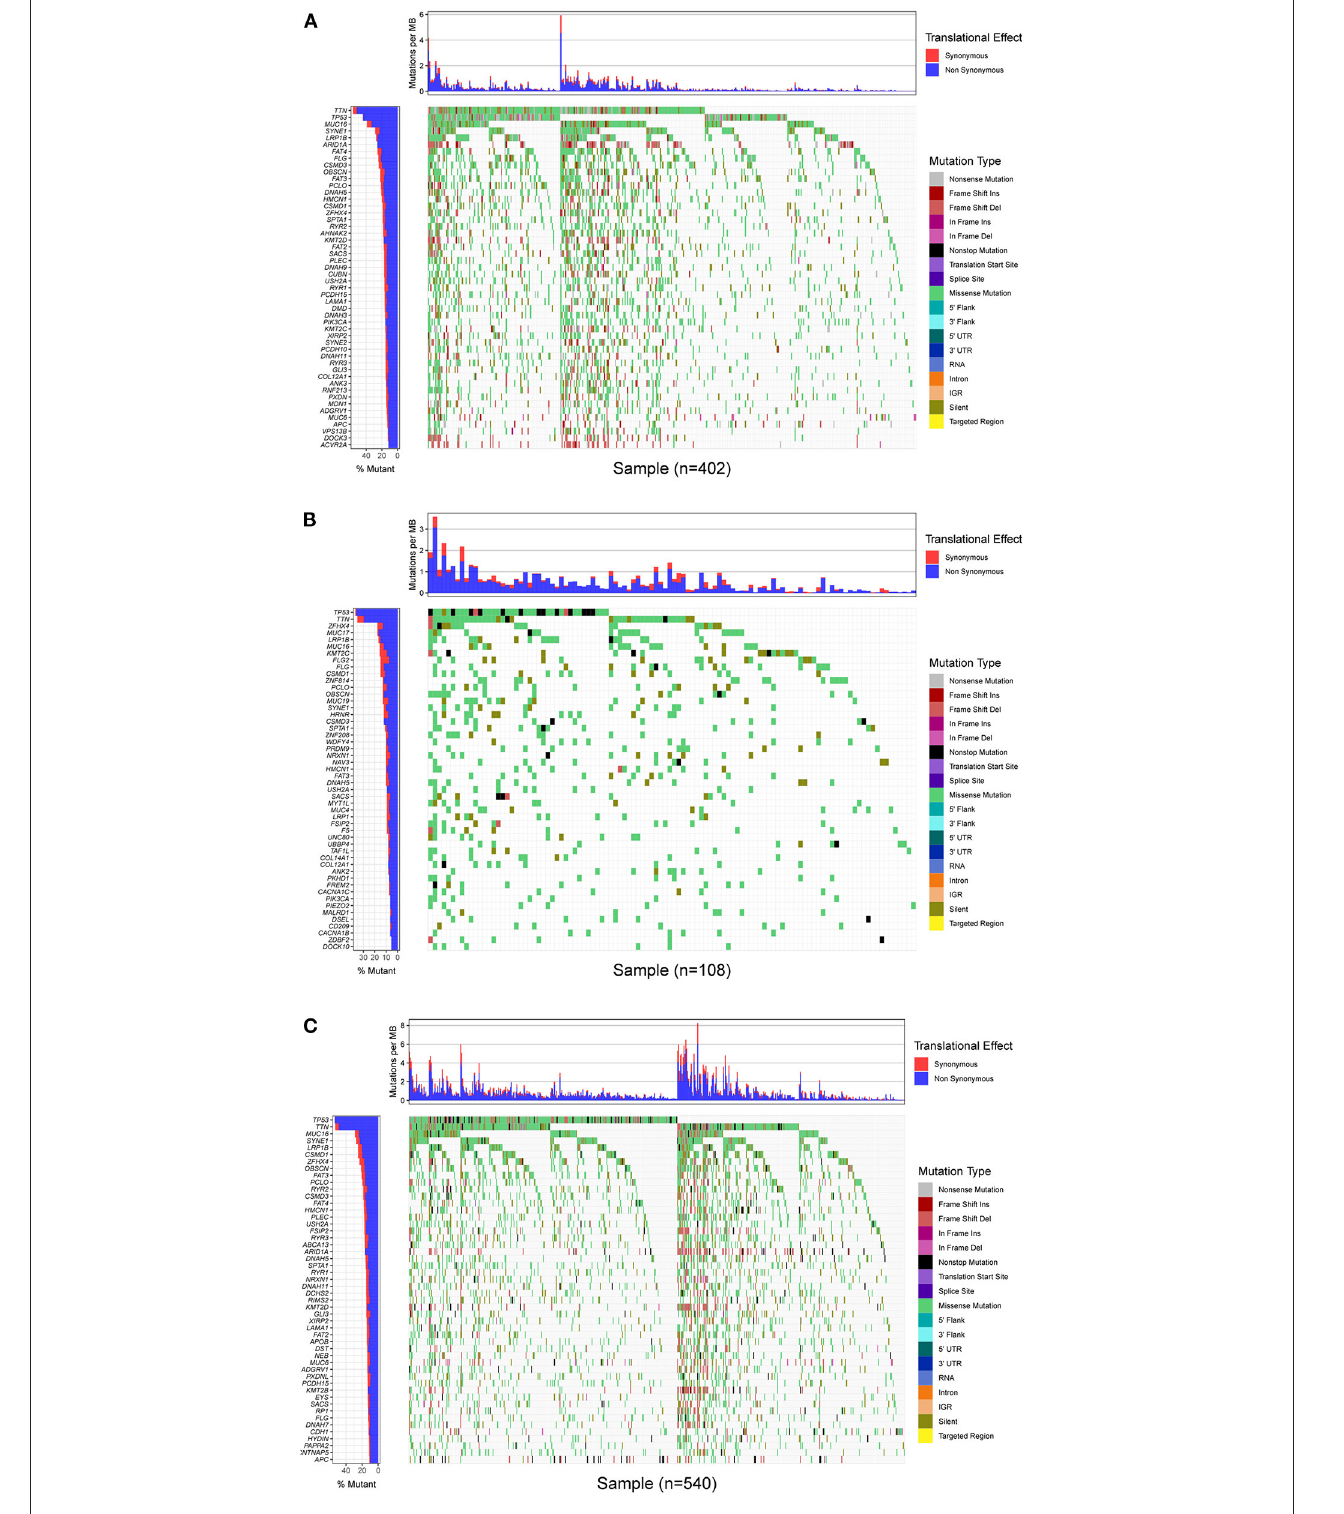
FIGURE 2 | Mutational landscape of GC. (A) Waterfall plot of TCGA-STAD cohort. (B) Waterfall plot of ICGC-China cohort. (C) Waterfall plot of ICGC-China cohort. Annotations on right-hand side represent mutation types. Bar plot on left-hand side shows distribution of mutation types among top 50 genes. GC, gastric cancer; TCGA, The Cancer Genome Atlas; STAD, stomach adenocarcinoma; ICGC, International Cancer Genome Consortium.